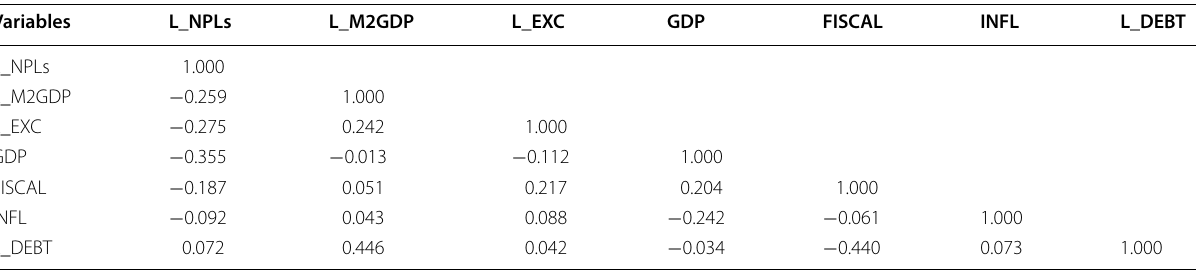
Table 3 Matrix of